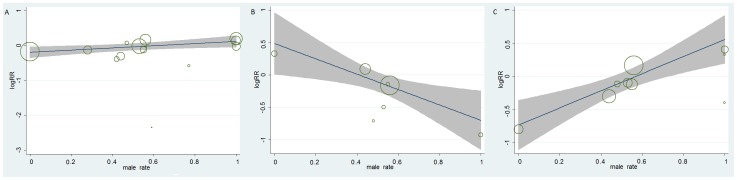
Meta-regression between male percentage and the effects of aspirin on risk of MI or stroke.(A) Log relative risk of stroke in relation to male percentage in all people. (B) Log relative risk of MI in relation to male percentage in diabetic patients. (C) Log relative risk of stroke in relation to male percentage in diabetic patients. The gray bonds in each figure are confidence interval. The size of the bubble represents the value of the weight. MI = myocardial infarction.